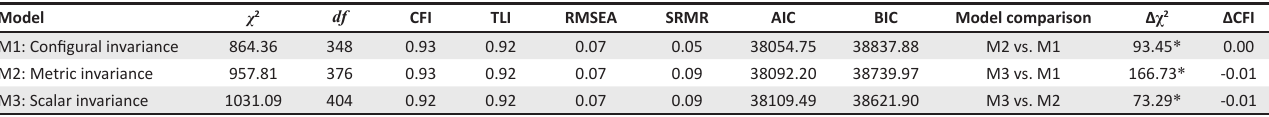
TABLE 7: Invariance testing between the different generational cohorts.